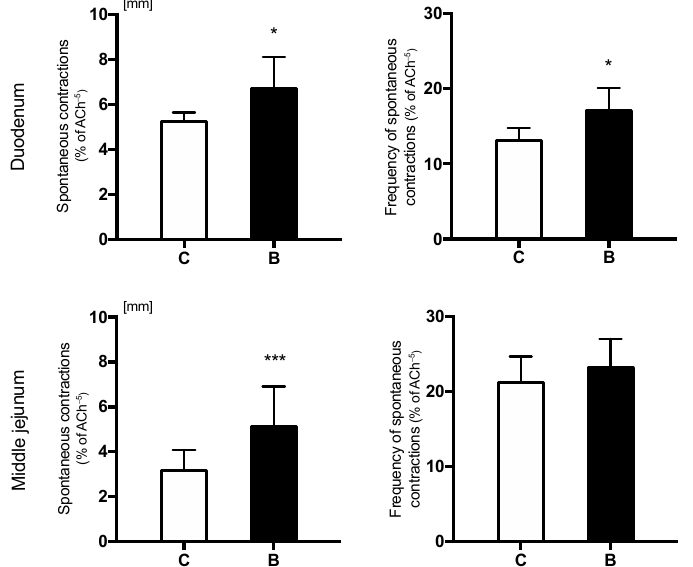
Figure 2. Amplitude of contractions (mm) of isolated duodenal and middle jejunum fragments in control (C) and sodium-butyrate-treated piglets (B). Values are given as means ± SD; * indicates statistical differences between groups when * p < 0.05, *** p < 0.001.